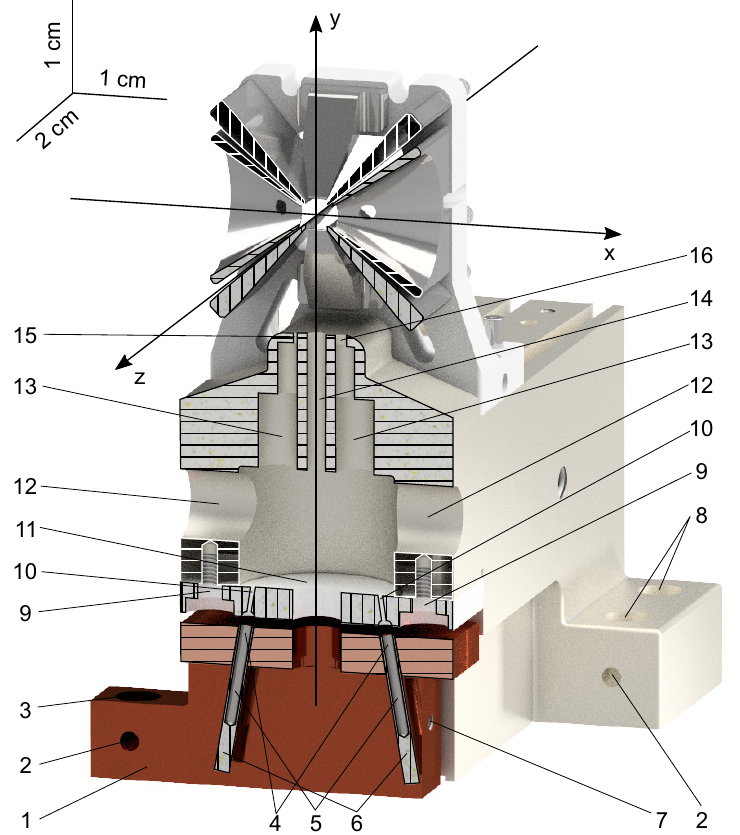
Figure 5. CAD section of the oven system for producing atomic beams of neutral barium. (1) Copper heat-sink. (2) Venting holes. (3) Screw passing hole for fixing the heat-sink on the flange. (4) Cold upper part of the (5) tubes. (6) Tube stripes for the electric connections. (7) Threaded hole for the ground connecting the heat-sink. (8) Screw passing holes for fixing the base on the flange. (9) Pipes and (10) screw passing holes of the cold ceramic (11) skimmer. (12) Inspection viewports of the (13) cylindrical oven cavities. (14) Anti-sputter wall for protecting the vertical optical access. (15) and (16) Output